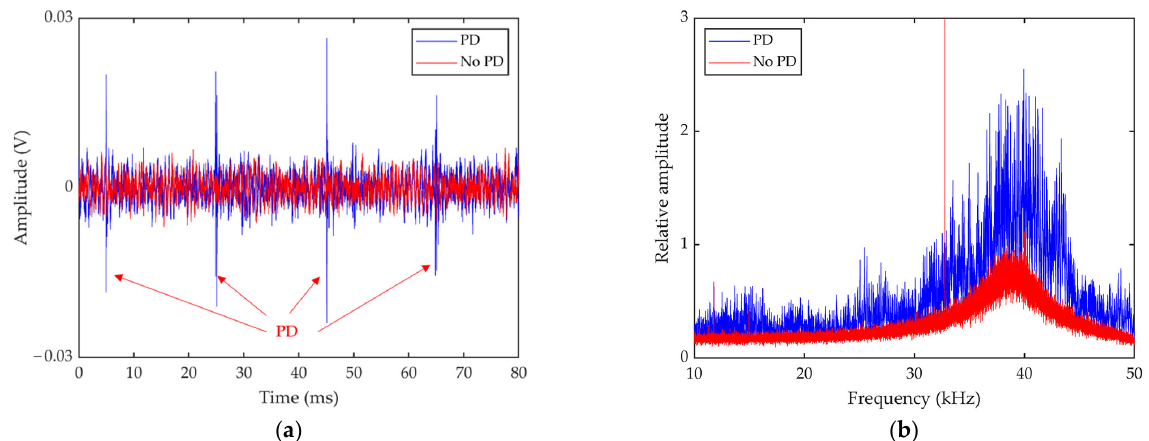
Figure 10. Time domain signal ( a ) from a microphone channel and the corresponding frequency domain information ( b ).